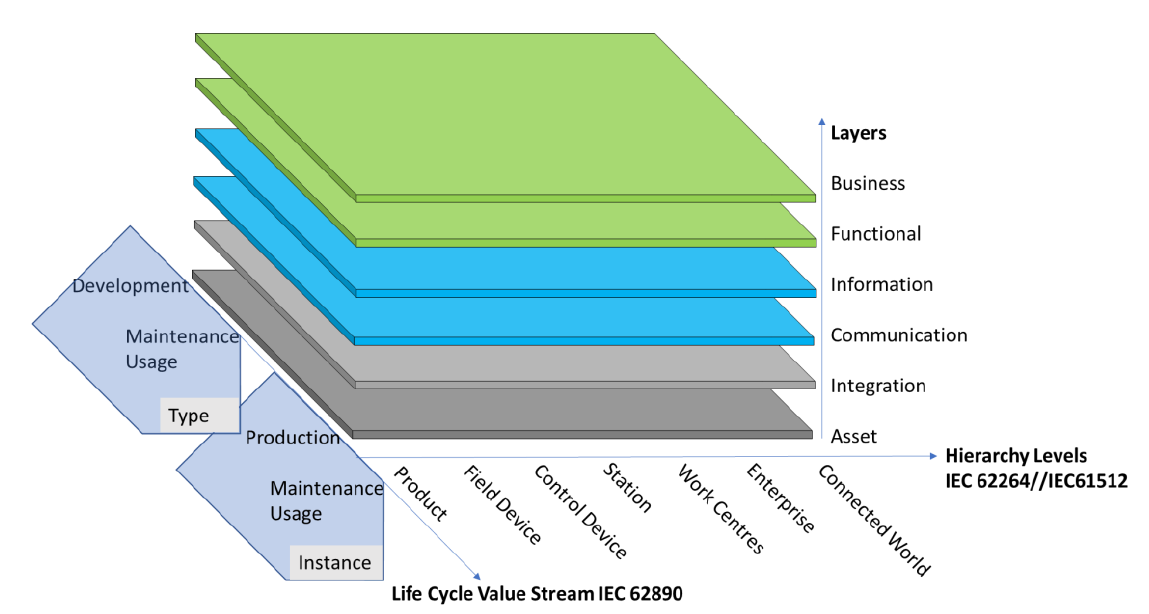
Figure 11. Evolution of hierarchical ISA-95 architecture to a CPPS distributed model.